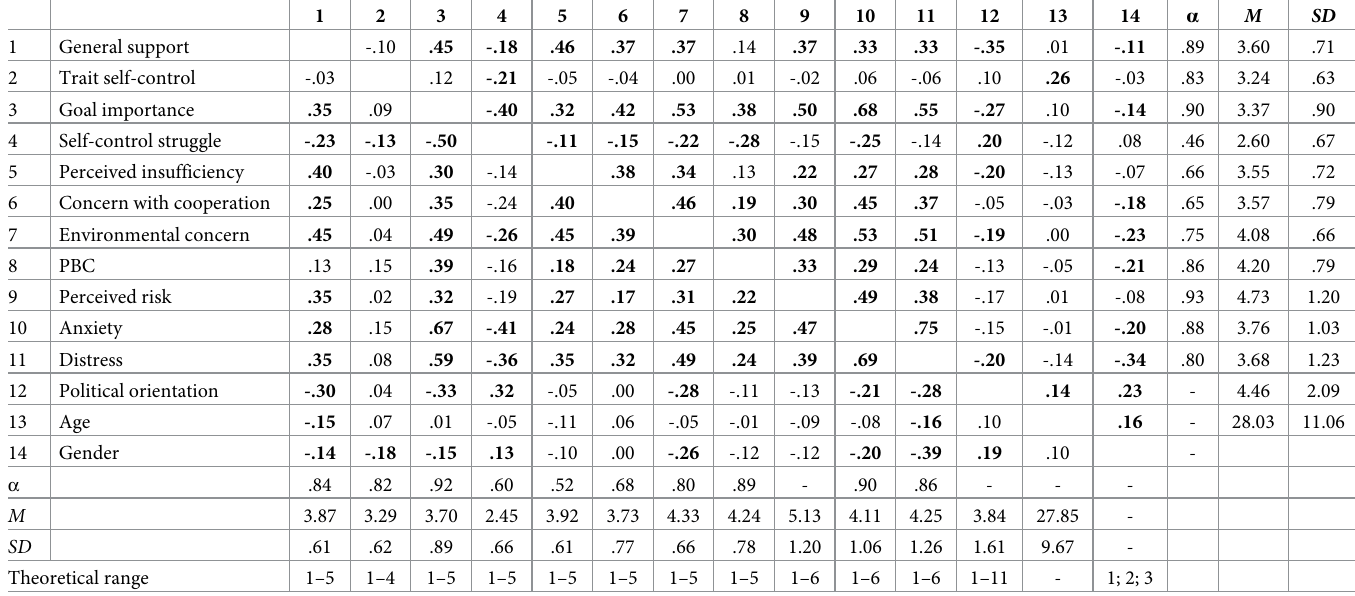
Table 1. Summary of intercorrelations, internal consistencies, means, and standard deviations for all study variables by